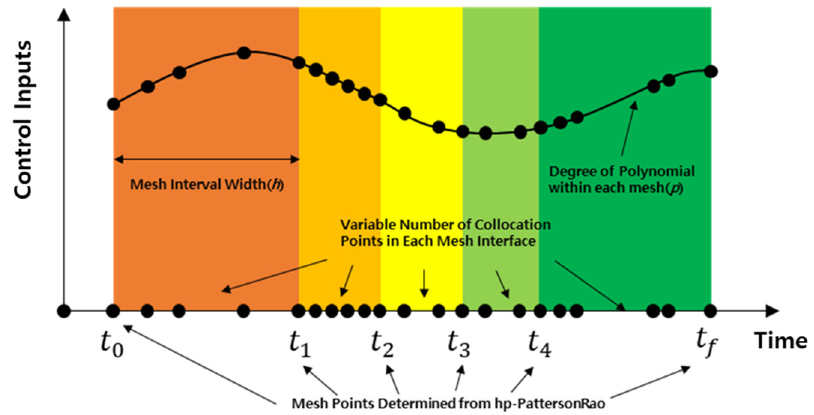
Figure 15. Conceptual scheme of a hp-PattersonRao on GPOPS-II.